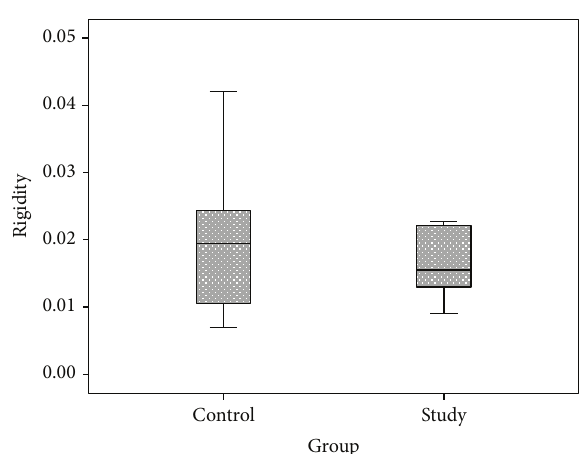
Figure 2: Ocular rigidity ( 𝜇 L −1 ). Boxplots of mean ocular rigidity coefficient in NPDR group ( 𝑛 = 24 ) and control group ( 𝑛 = 24 ).